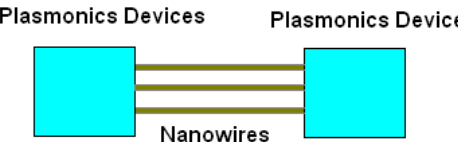
Fig. 1: A ge neralized st ructure for c oupled approach, in which plasmonics devices are interconnected via